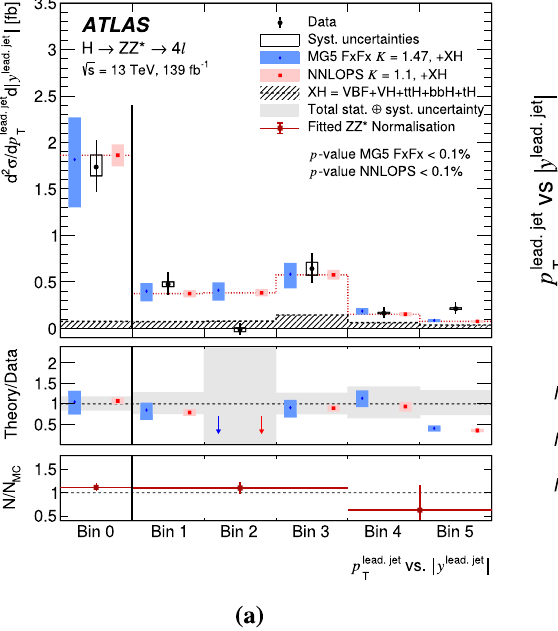
matrix between the measured cross sections and the Z Z ∗ back- ground normalisation factors. The bin boundaries are defined in Fig.